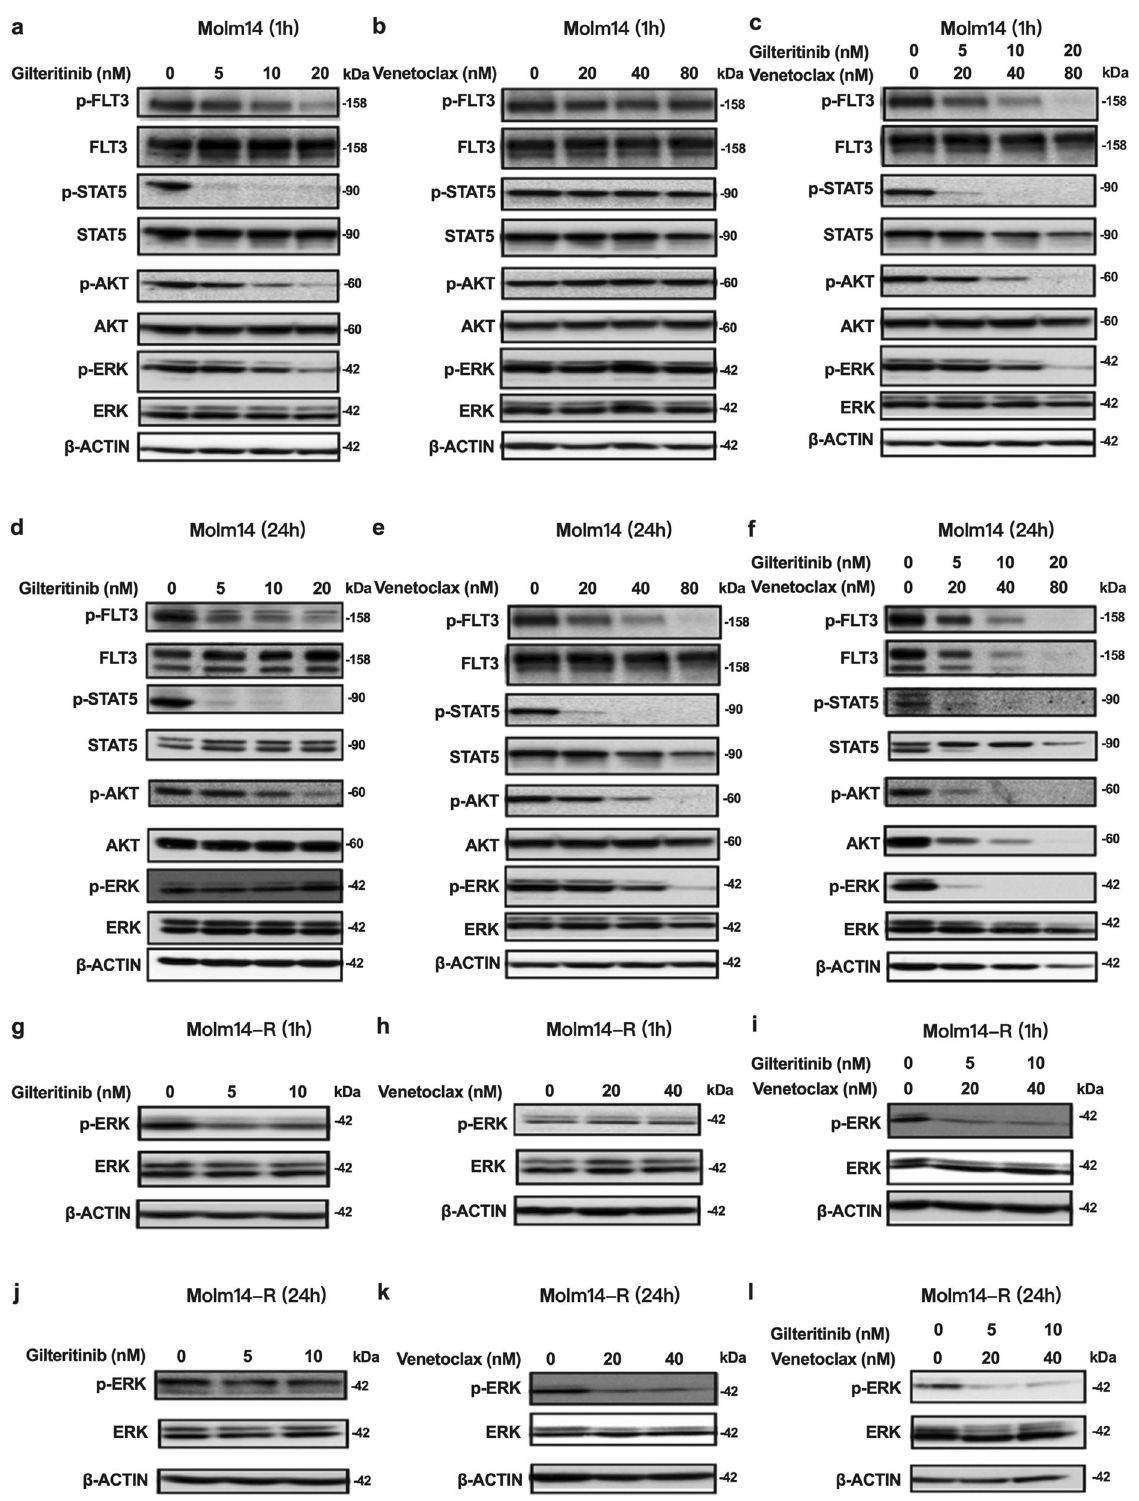
Fig. 3 Venetoclax sensitizes TKI-resistant FLT3/ITD cells to TKI treatment through inhibiting the MAPK/ERK pathway. Western blot analysis for FLT3 and downstream signaling pathways in Molm14 cells treated for 1 h with the indicated concentrations of a Gilteritinib, b Venetoclax, and c the combination. In all, 24 h Western blot analysis for FLT3 and downstream signaling pathways in Molm14 cells treated with the indicated concentrations of d Gilteritinib, e Venetoclax, and f the combination. 1 h western blot analysis for FLT3 downstream signaling pathways in Molm14-R cells treated with the indicated concentrations of ( g ) Gilteritinib, ( h ) Venetoclax, and ( i ) the combination. In all, 24 h western blot analysis for FLT3 downstream signaling pathways in Molm14 cells treated with the indicated concentrations of ( j ) Gilteritinib, ( k ) Venetoclax, and ( l ) the combination